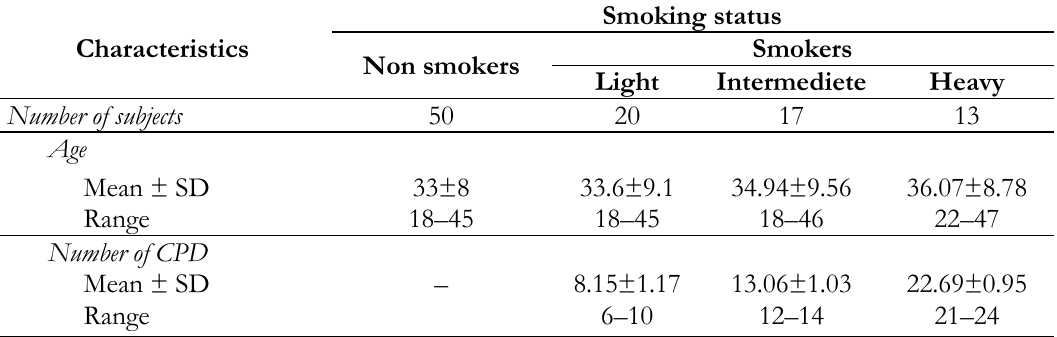
Table I. Demographic characteristics and CYP2A6 genotypes of subjects according to